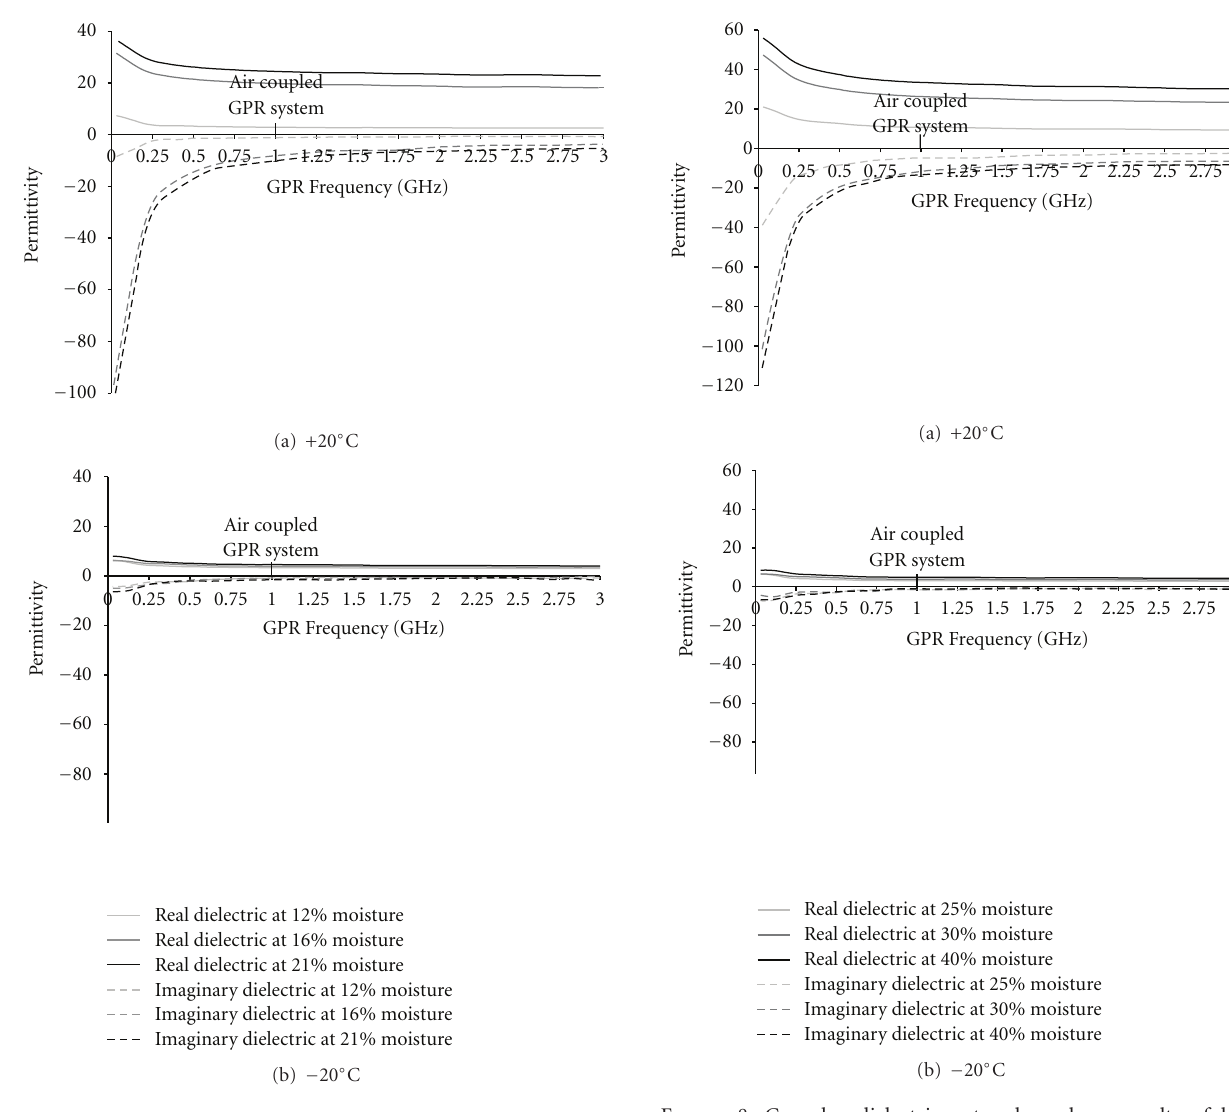
Figure 7: Complex dielectric network analyzer results of interme- diate plastic clay-till.